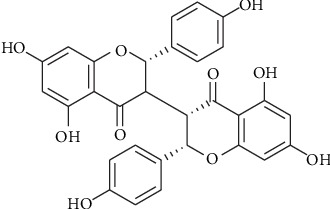
Structure of NCA.